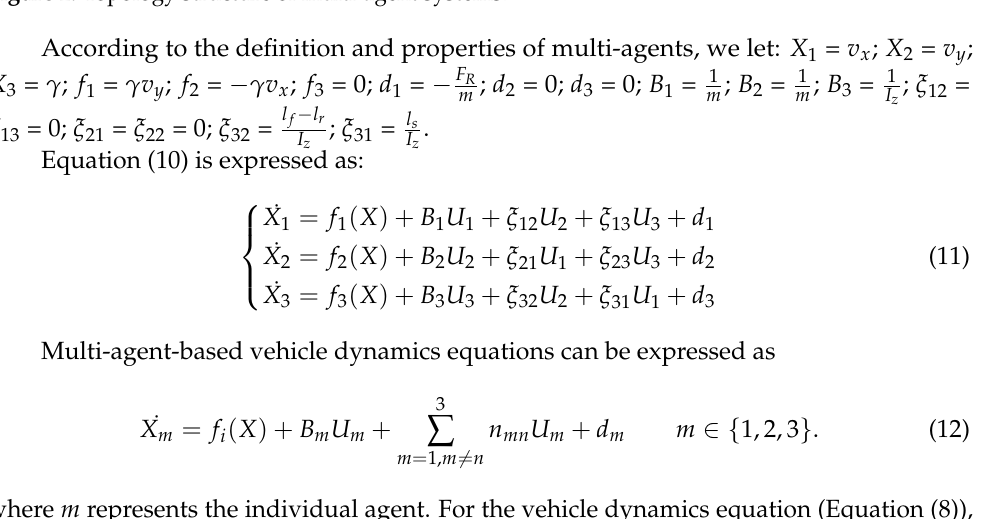
Figure 2. Topology structure of multi-agent